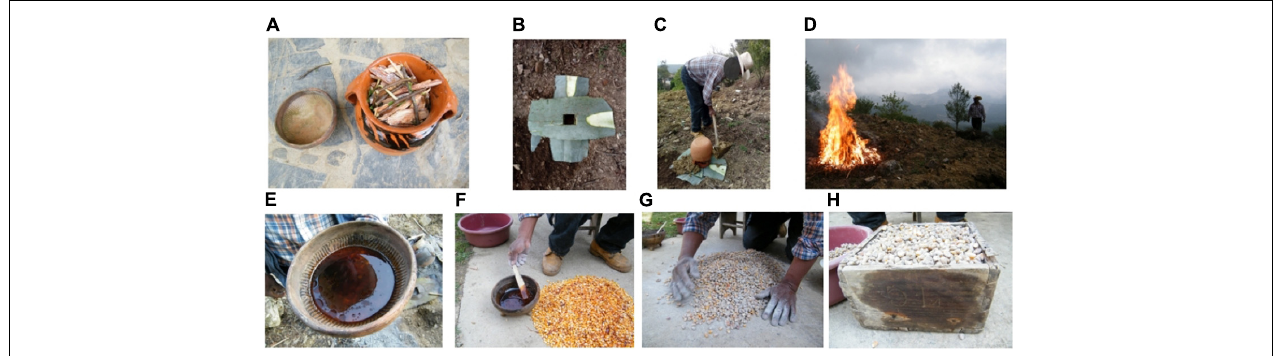
FIGURE 6 | Prevention of corn seed predation by mammals. (A) Pinus sp. Chips are extracted (ca. 1 kg) and placed in a clay pot. A clay molcajete is also shown (left). (B) The clay molcajete is placed in a hole below the earth and covered with two Agave americana leaves with a hole in the middle. (C) The chips inside the pot are placed on the top and sealed to the A. americana leaves with fresh clay. (D) The system is covered with branches and a fire is kept alive for 1 h before the sunset. After extinguishing the fire, the system is left to work all night. (E) The next morning, the resin can be collected from the molcajete. (F,G) The resins and ashes are spread over the seeds and mixed. (H) the seeds are ready to be sown or